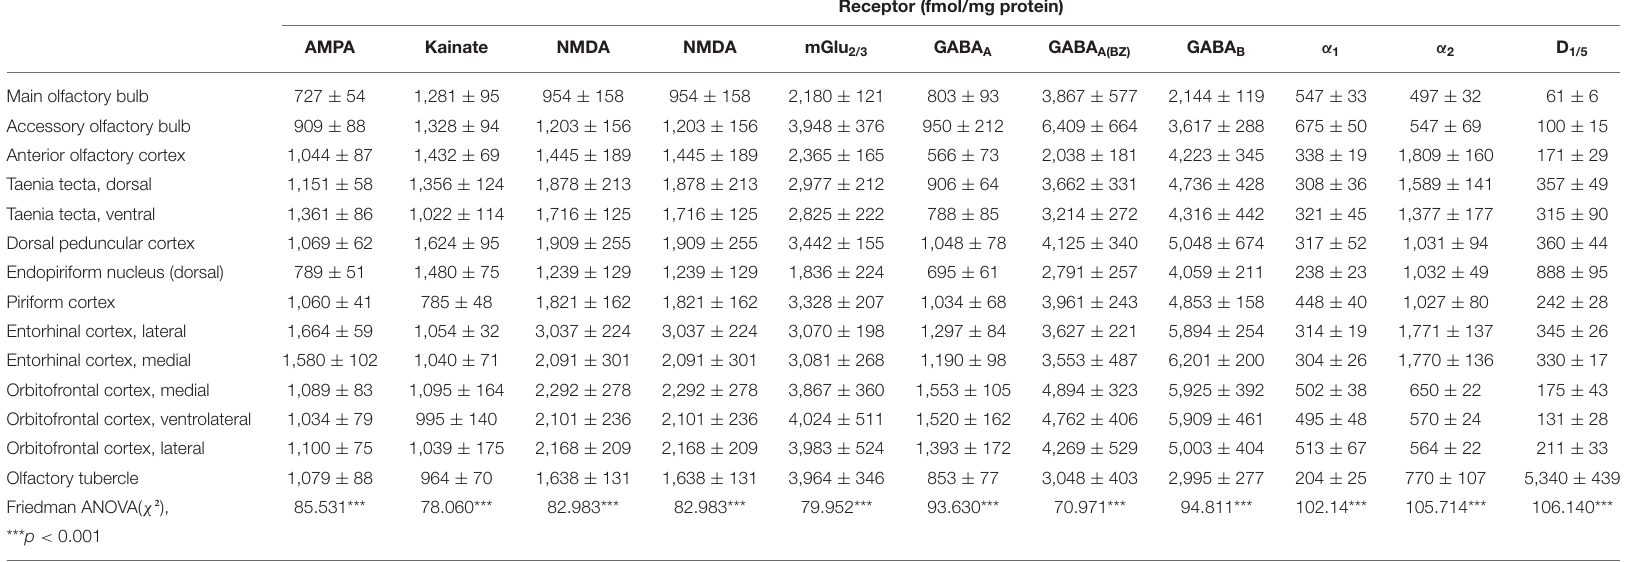
TABLE 1 | Neurotransmitter receptor densities (fmol/mg protein) in different regions of the mouse olfactory system (Mean ±